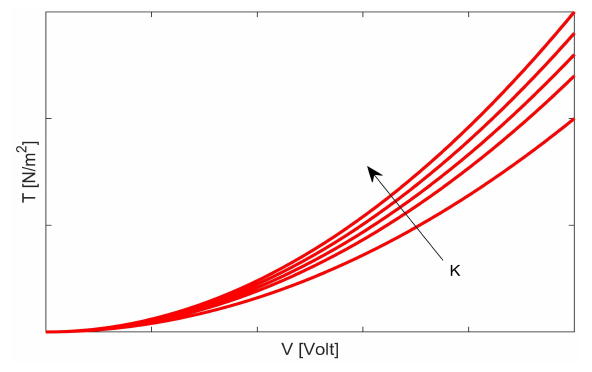
Figure 10. Geometric link between T and V